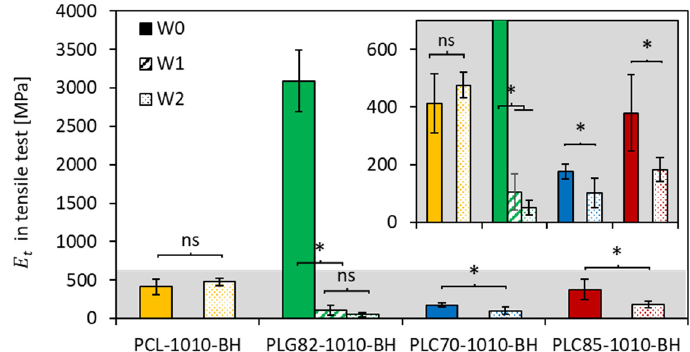
Figure 5. Results of 𝐸 (cid:3047) from tensile test performed in PBS at 37 °C (insert presents a range of 0–700 MPa); *—when p < 0.05, ns-when p ≥ 0.05 in post hoc one-way ANOVA with a Tukey–Kramer pair-wise comparison test.